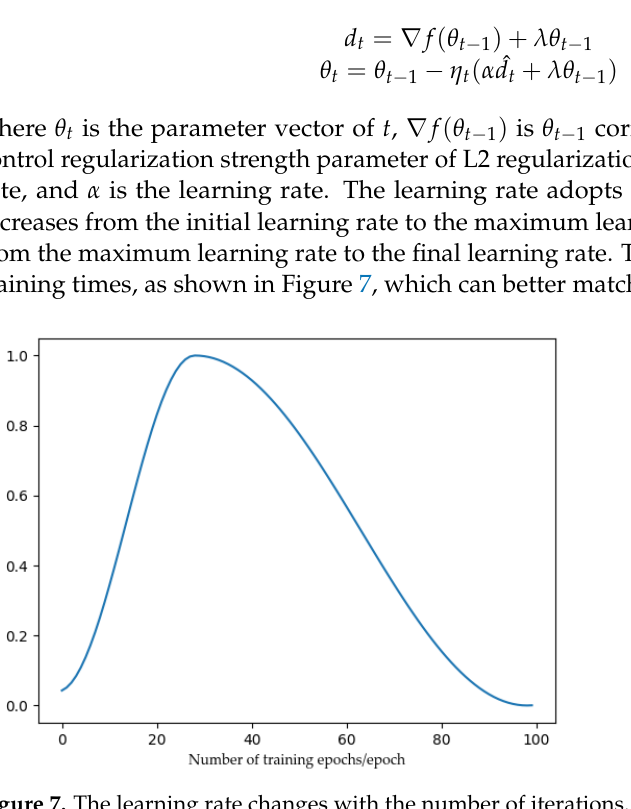
Figure 7. The learning rate changes with the number of